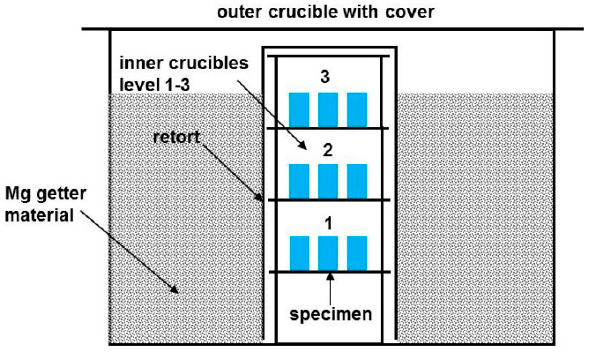
Figure 4. Labyrinth like crucible setup necessary for the sintering of MIM Mg alloy parts.